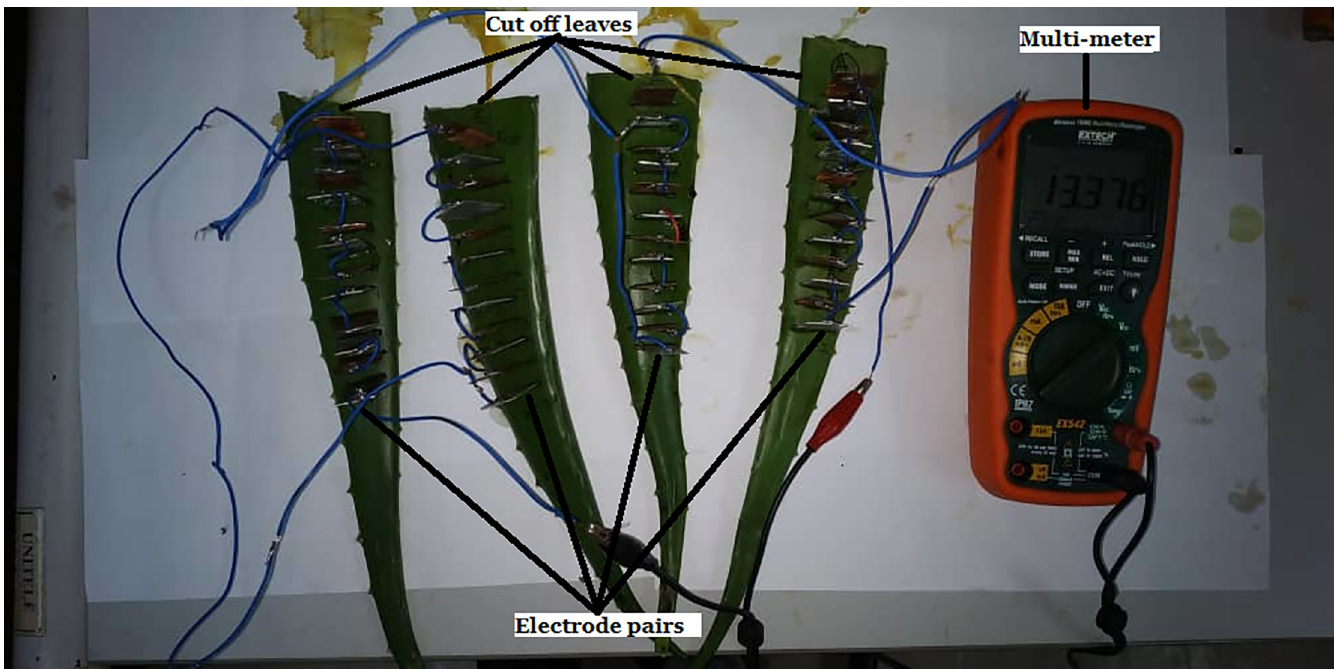
Fig 11. The equivalent circuit for series connection between cut off leaves. https://doi.org/10.1371/journal.pone.0218758.g011 from the zinc electrode (Zn(s) ! Zn2+ (aq) + 2e-) which flows through the external wire to the load (multi-meter) and later towards the copper electrode. Reduction takes place at the copper electrode. The Aloe Vera inner semi-solid fleshy gel acts as the electrolyte. The direction of the electron flow is determined by the ease of oxidization level between two electrodes. As zinc is more reactive than copper and it has a stronger tendency to lose elec- trons, hence this causes the electron to flow from zinc electrode to copper electrode. The whole system, which operates similar to a voltaic cell, makes the zinc electrode as the anode, the negative terminal and the copper as the cathode, the positive terminal. This gives the cur- rent, which is holes to flow from copper (cathode) to zinc (anode).